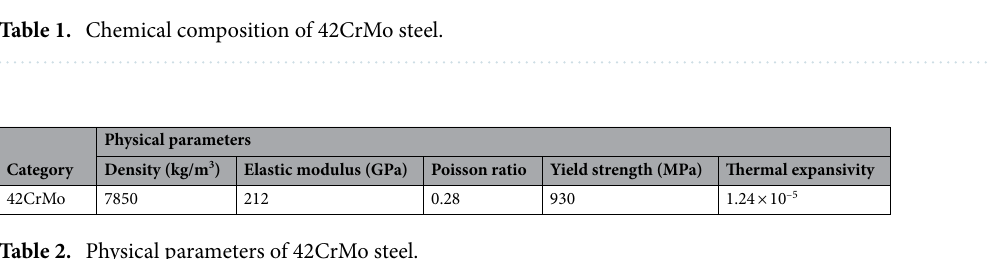
Table 2. Physical parameters of 42CrMo steel.